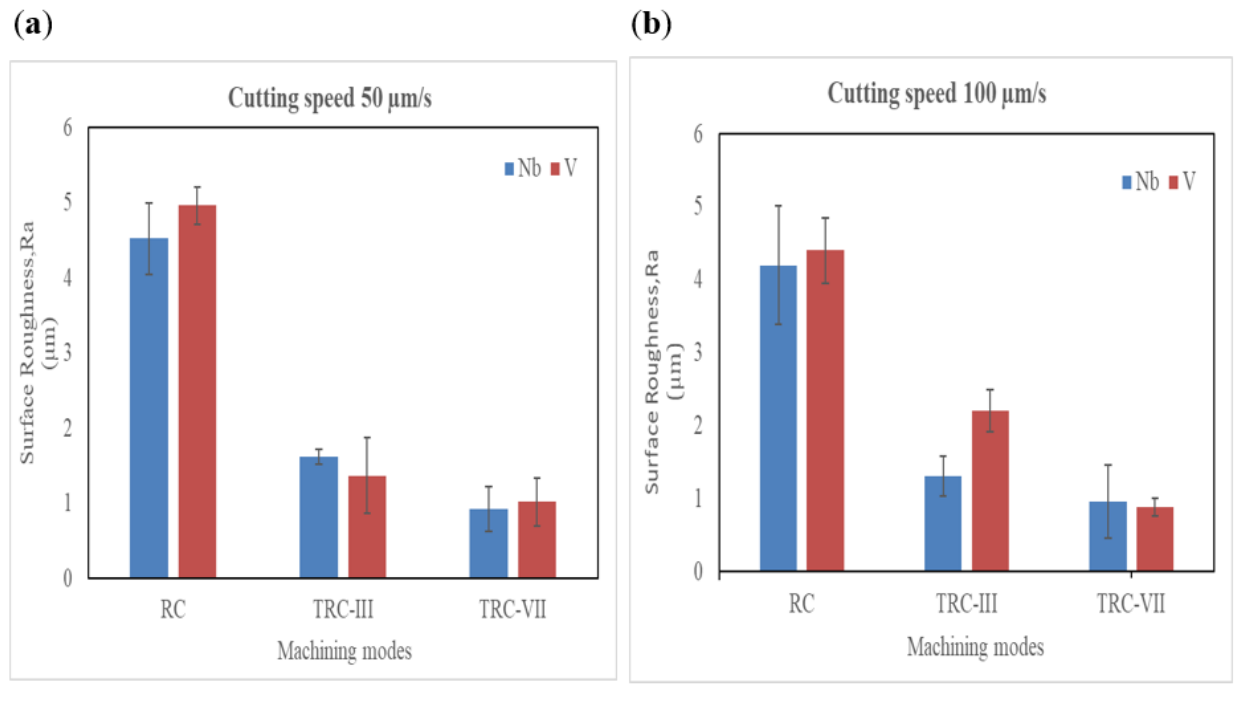
Figure 12. Surface roughness of Ti-6Al-4V and Ti-6Al-7Nb: ( a ) Comparison at cutting speed 50 µm/s, ( b ) at 100 µm/s of machined samples. Table 3. Experimental plan and related